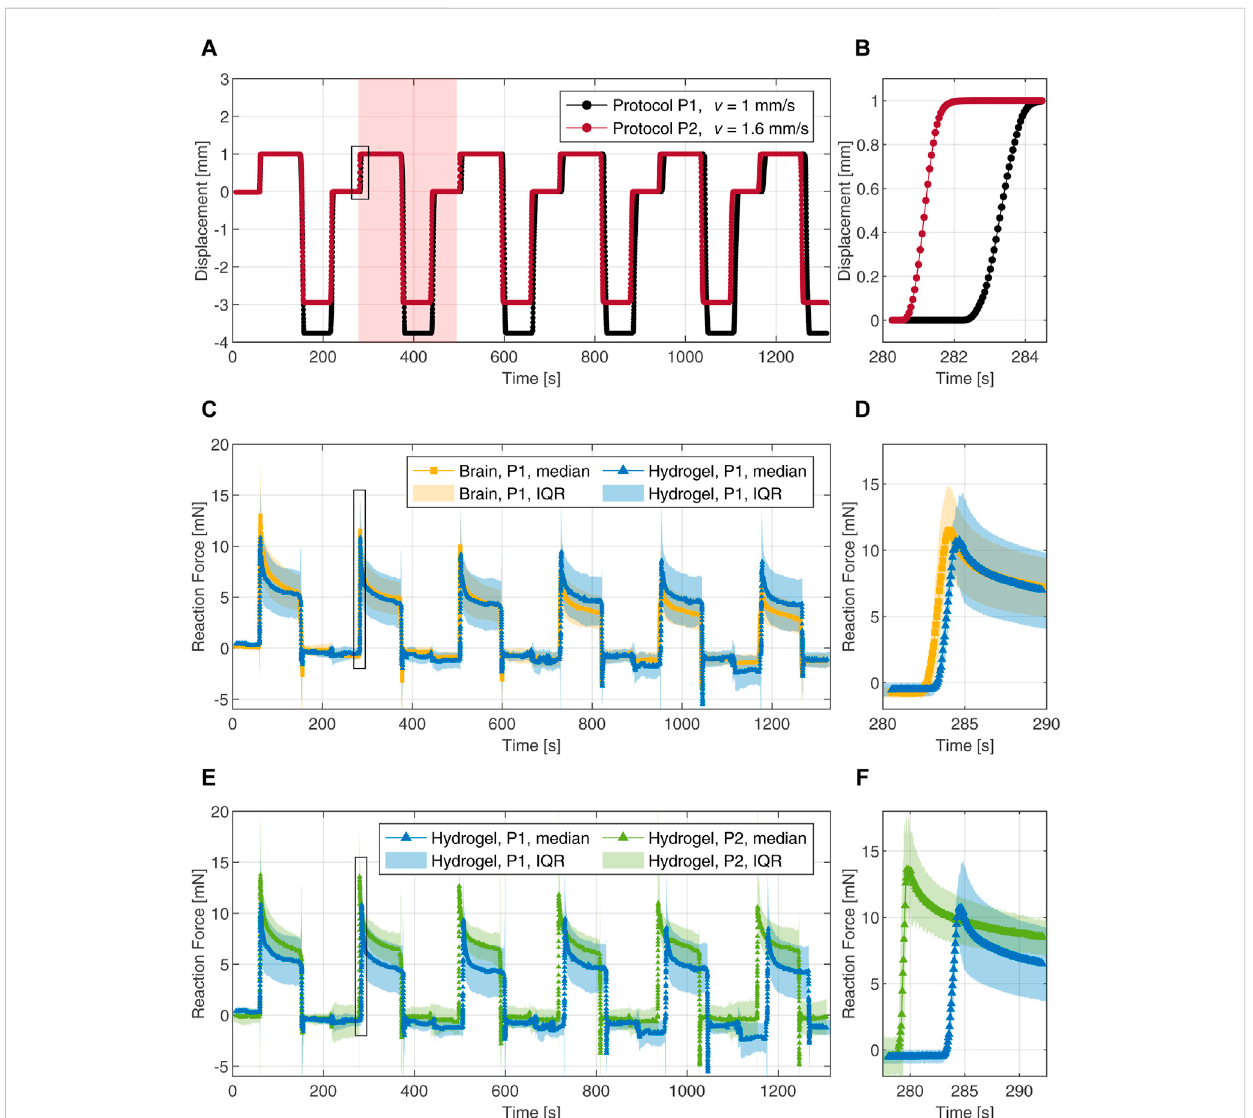
FIGURE 4 Cyclic indentation tests with a 4 mm fl at-punch. (A) Loading protocols with two different speeds represented by time-displacement curves. The shaded area highlights one complete indentation cycle. (B) Magni fi cation of the loading part during the second indentation cycle. (C) Force-time responses of the composite hydrogel (blue) and porcine brain tissue (yellow) during six indentation cycles. (D) Magni fi cation of the force-time response upon loading during the second cycle. (E) Force-time responses of the composite hydrogel probed with two different loading rates. (F) Magni fi cation of the force-time response upon loading during the second cycle. The data is represented by the median and the interquartile range (IQR). The magni fi cations in the right column are marked with black frames in the corresponding fi gures to the